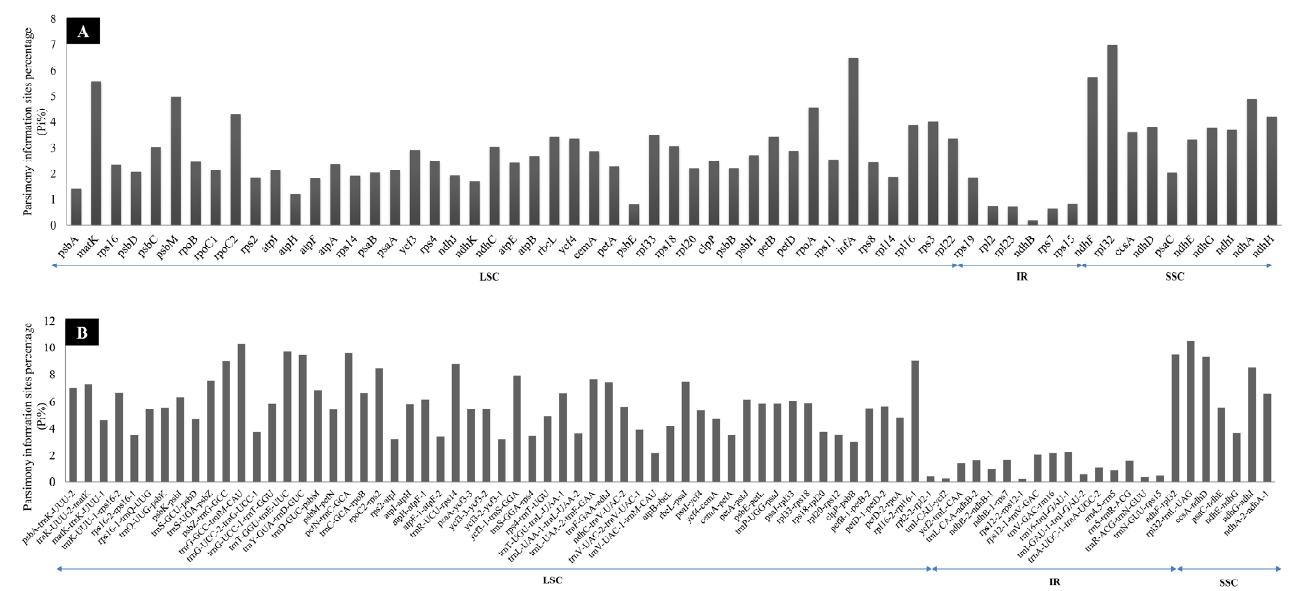
Figure 5. The homologous comparison of 16 Aristidoideae plastomes by mVISTA, with St. pennata as a reference. The horizontal axis, which represents the percentage of identity, ranges from 50–100%. Different colors indicate different gene regions.